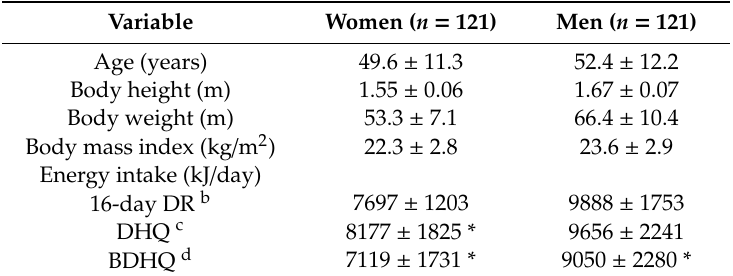
Table 1. Basic characteristics of study participants a